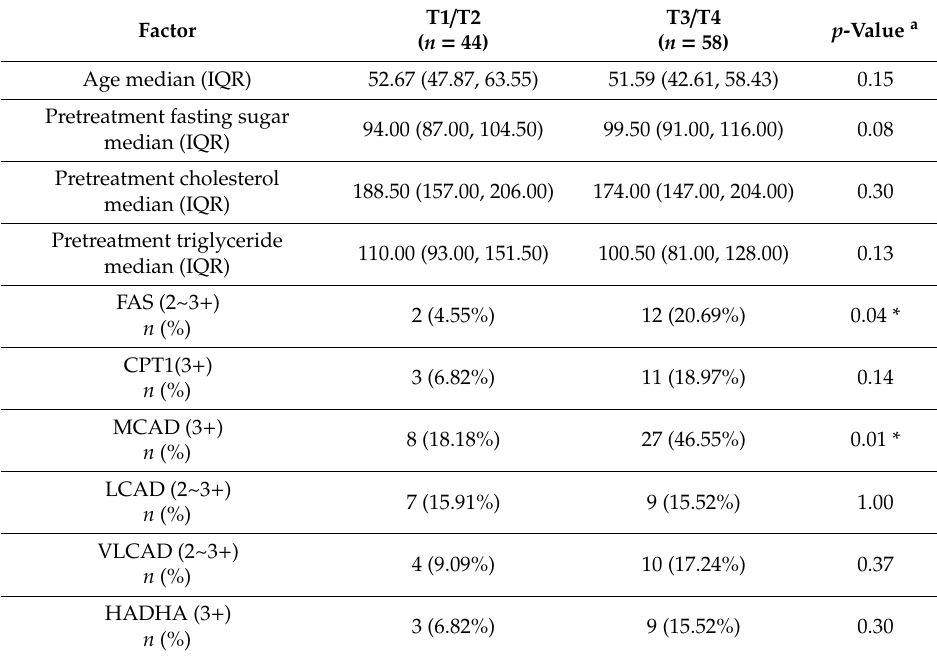
Table 4. Correlations between T stage and patients’ characteristics ( n =